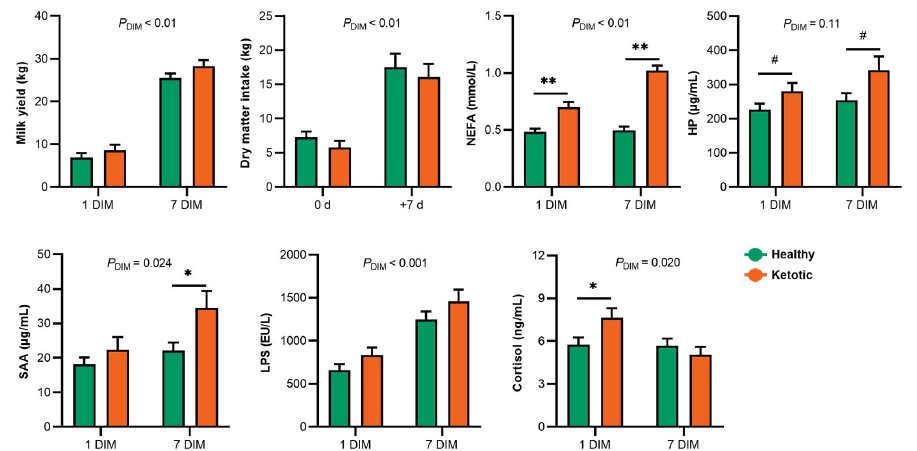
Figure 1. Bar plot indicating the changes in dry matter intake, milk yield, non ‐ esterified fatty acids (NEFA), haptoglobin (HP), serum amyloid A (SAA), lipopolysaccharide (LPS), and cortisol between the healthy and ketotic cows at 1 and 7 days in milk (DIM). 0.05 ≤ # p < 0.1, * p < 0.05, and ** p < 0.01.